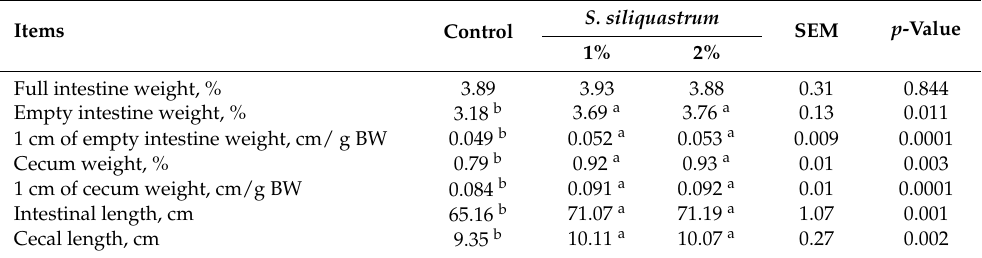
Table 5. Effect of S. siliquastrum dietary treatment on weight and length of intestines and cecum in Japanese quails.